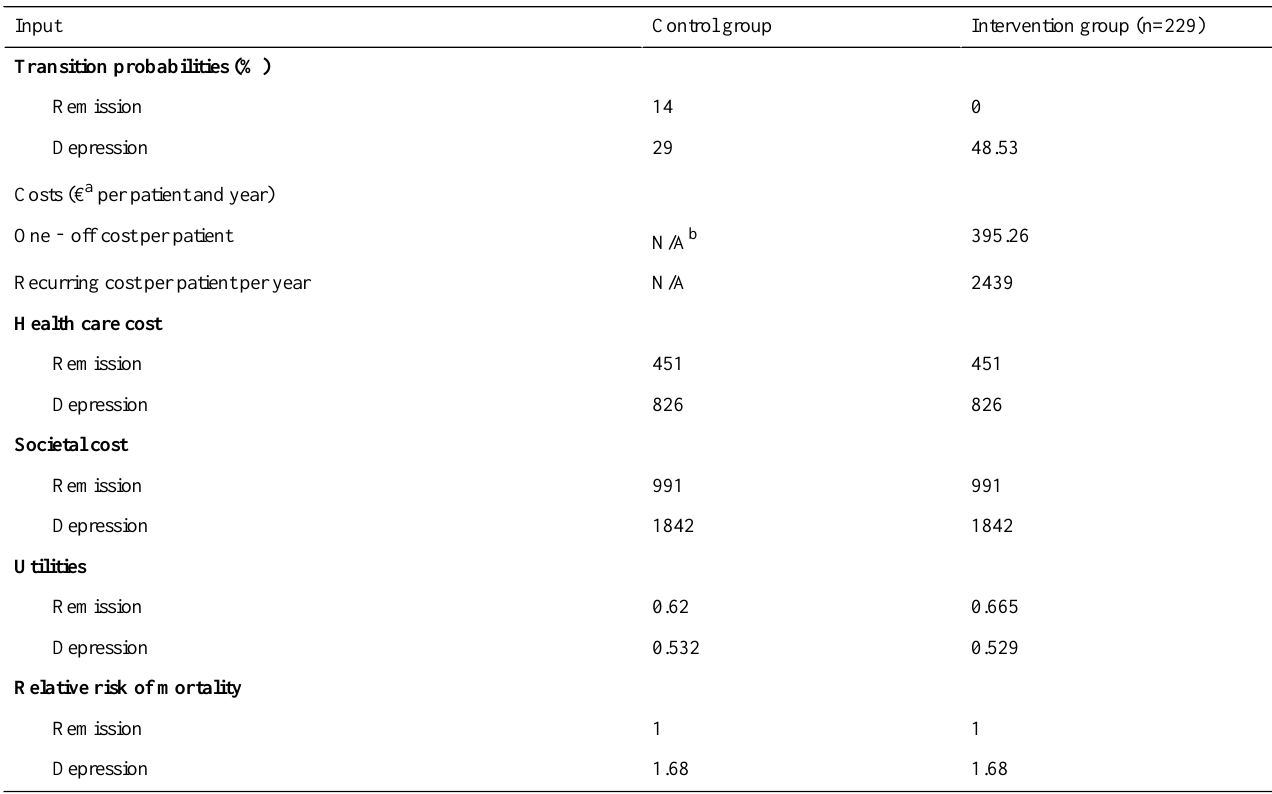
Table 2. Inputs of the MAFEIP tool for computing the cost-effectiveness analysis.